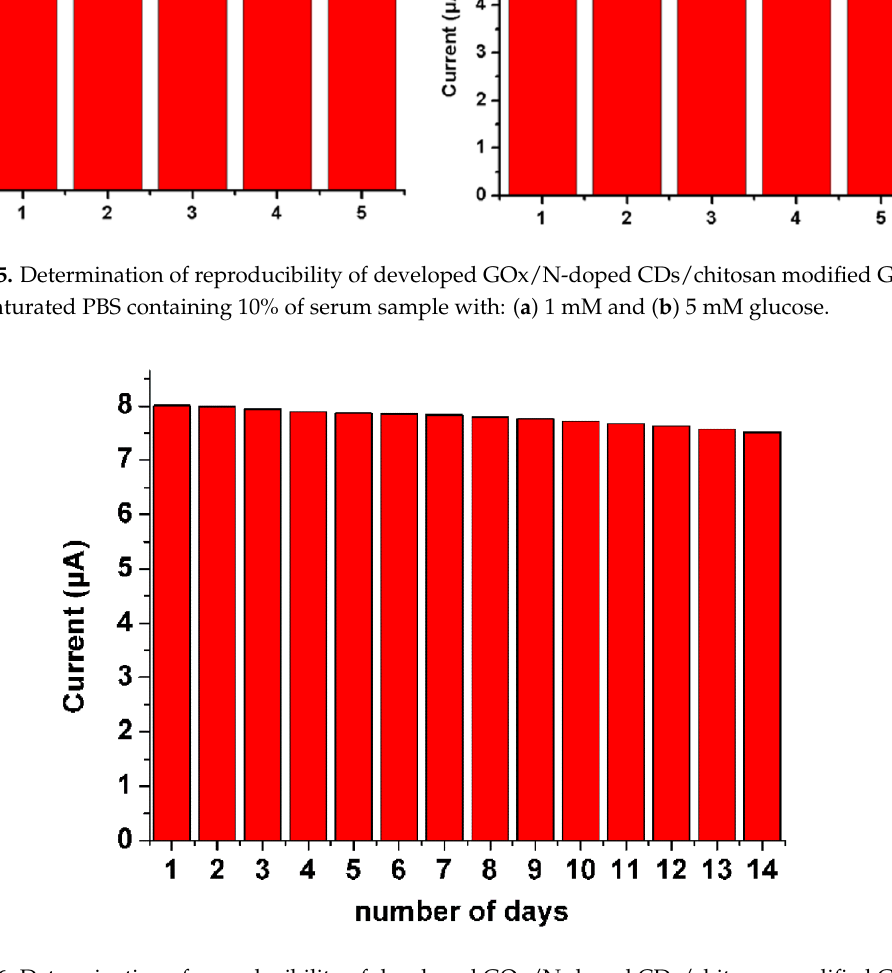
Figure 6. Determination of reproducibility of developed GOx/N-doped CDs/chitosan modified GCE in air-saturated PBS with 1 mM a glucose and in air-saturated PBS containing 10% of serum samples.